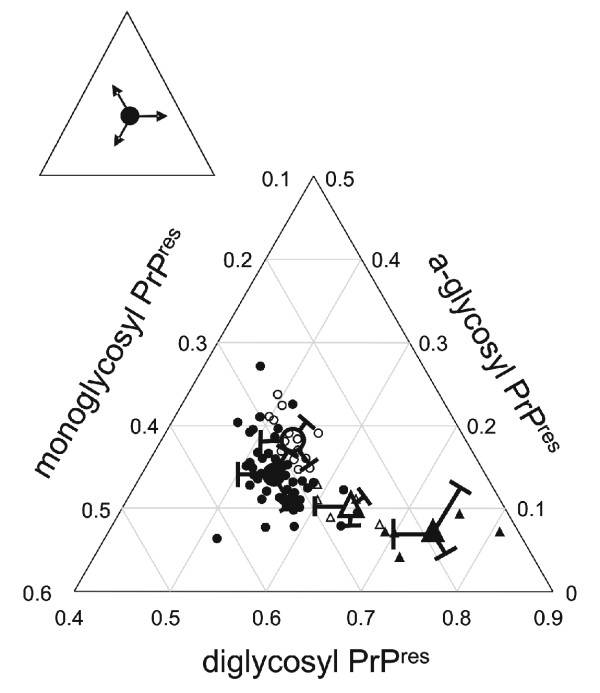
Glycoprofile of PrPres in RLN samples analyzed in scrapie and BSE infected sheep. Triangular presentation of the proportion of each of three glycoprofile components per individual RLN sample. Symbols correlate with group of sheep: ● – field cases, ◯ – scrapie cases in preclinical study (excluding 2 clinical cases), ▲ – sheep with experimental BSE, △ – sheep in preclinical stage of experimental BSE. The average and SDs per group is indicated by respectively the larger size symbols and bars. The small triangle diagram indicates in which direction from the axes each point should be read.